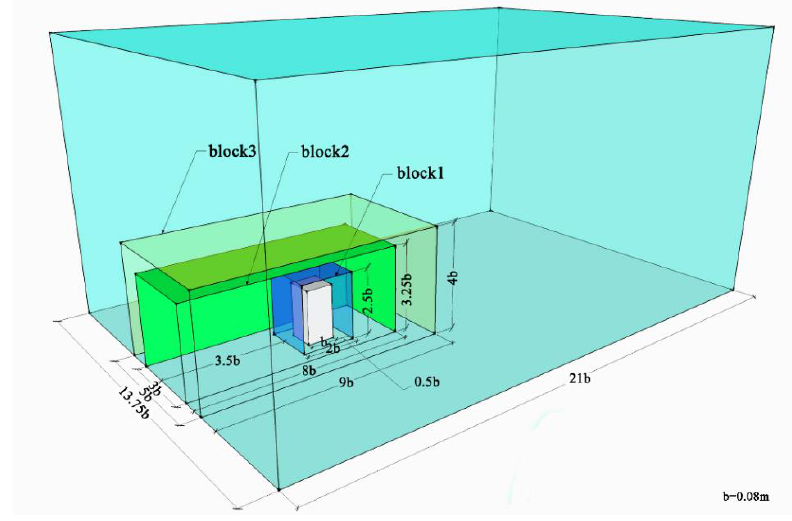
Figure 4. Location and size of blocks. Table 1. Block size and size ratio.